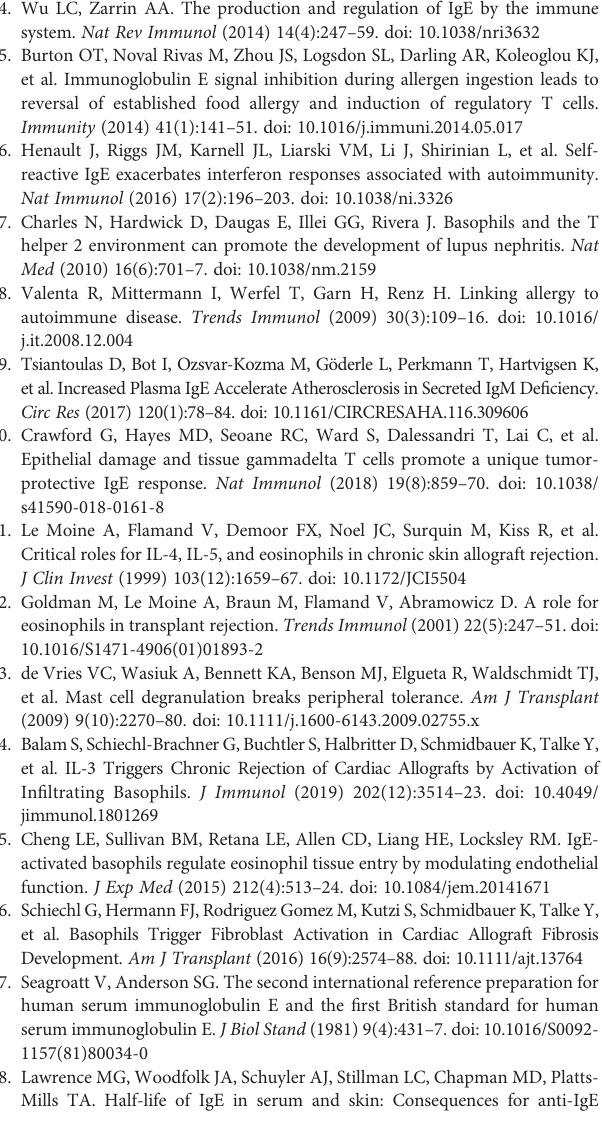
SUPPLEMENTARY FIGURE 1 | Luminex based measurement of HLA class I and II speci fi c IgE in human patient serum. Human serum from two patients (Patient 1 and Patient 2) and a healthy donor was incubated with either 1.5, 2, or 5 µl of beads speci fi c for HLA class I and II. (A) Positive IgE reactivities upon bead assay are